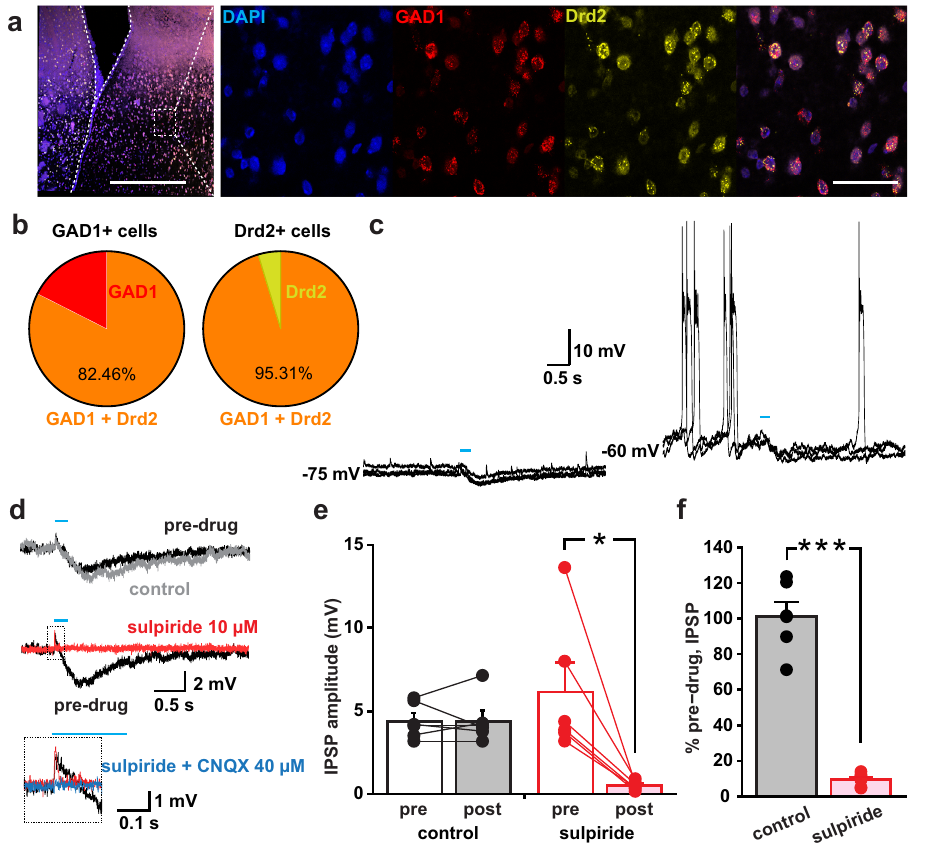
Fig. 5 DA acts to hyperpolarize LS projection neurons via D2 receptor activation. a Representative RNAscope image displaying colocalization of GAD1 (red) and Drd2 (yellow) mRNA in the LS; scale bars (500 and 50 µ m). b The pie diagrams show high GAD1 & Drd2 colocalization in the LS; 82.46% of GAD1 positive neurons were also positive for Drd2 and 95.31% of Drd2 positive neurons were also positive for GAD1. c Sample traces of IPSPs without current injection (at − 75 mV, left) and with the current injection to make the neuron fi re (at − 60 mV, right). Three traces are superimposed. Blue lines indicate the timing of train photo-stimulation ( fi ve pulses at 20 Hz). d Sample traces of IPSPs without depolarizing current injection before drug application (pre-drug), after 5 min application of control solution without drugs (control), and after 5 min application of sulpiride. The small EPSP in the dashed square of the middle panel is expanded below. The expansion shows a trace after application of sulpiride and CNQX. Each trace is an average from three consecutive traces. e IPSP amplitudes from each cell (circles) and means, for control recording and sulpiride application, during pre-drug period (pre) and 5 min after application (post). Lines connect data from the same recorded cells. f Percent pre-drug amplitude after application of control solution (gray bar) or sulpiride (pink bar). e , f n of recorded cells = 6 in each condition, n of recorded animals in e and f = 8 animals (six each for control and sulpiride; four pairs were from the same